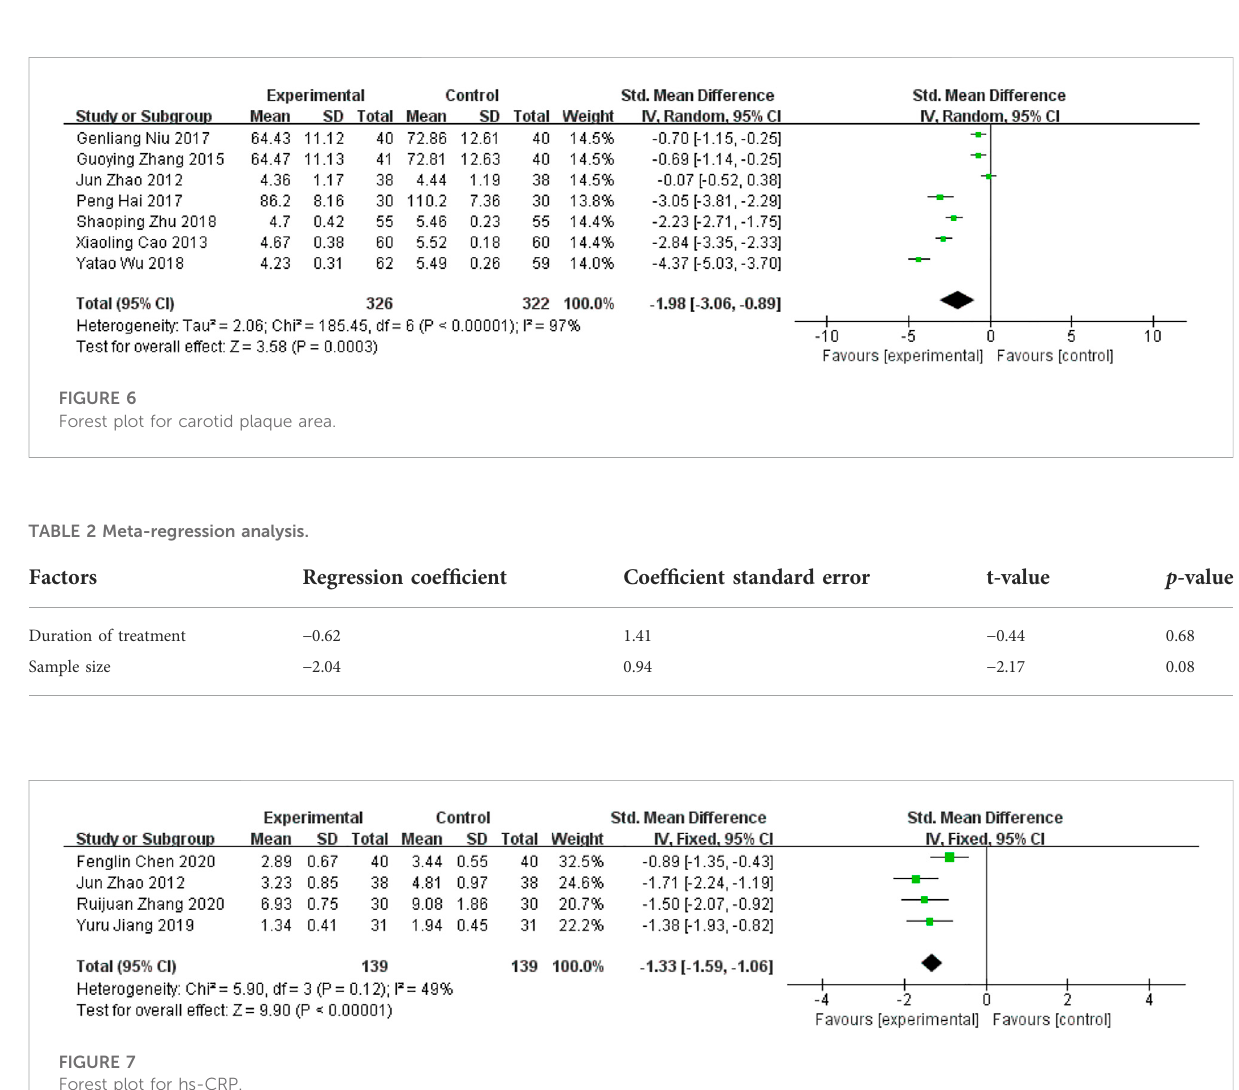
FIGURE 7 Forest plot for